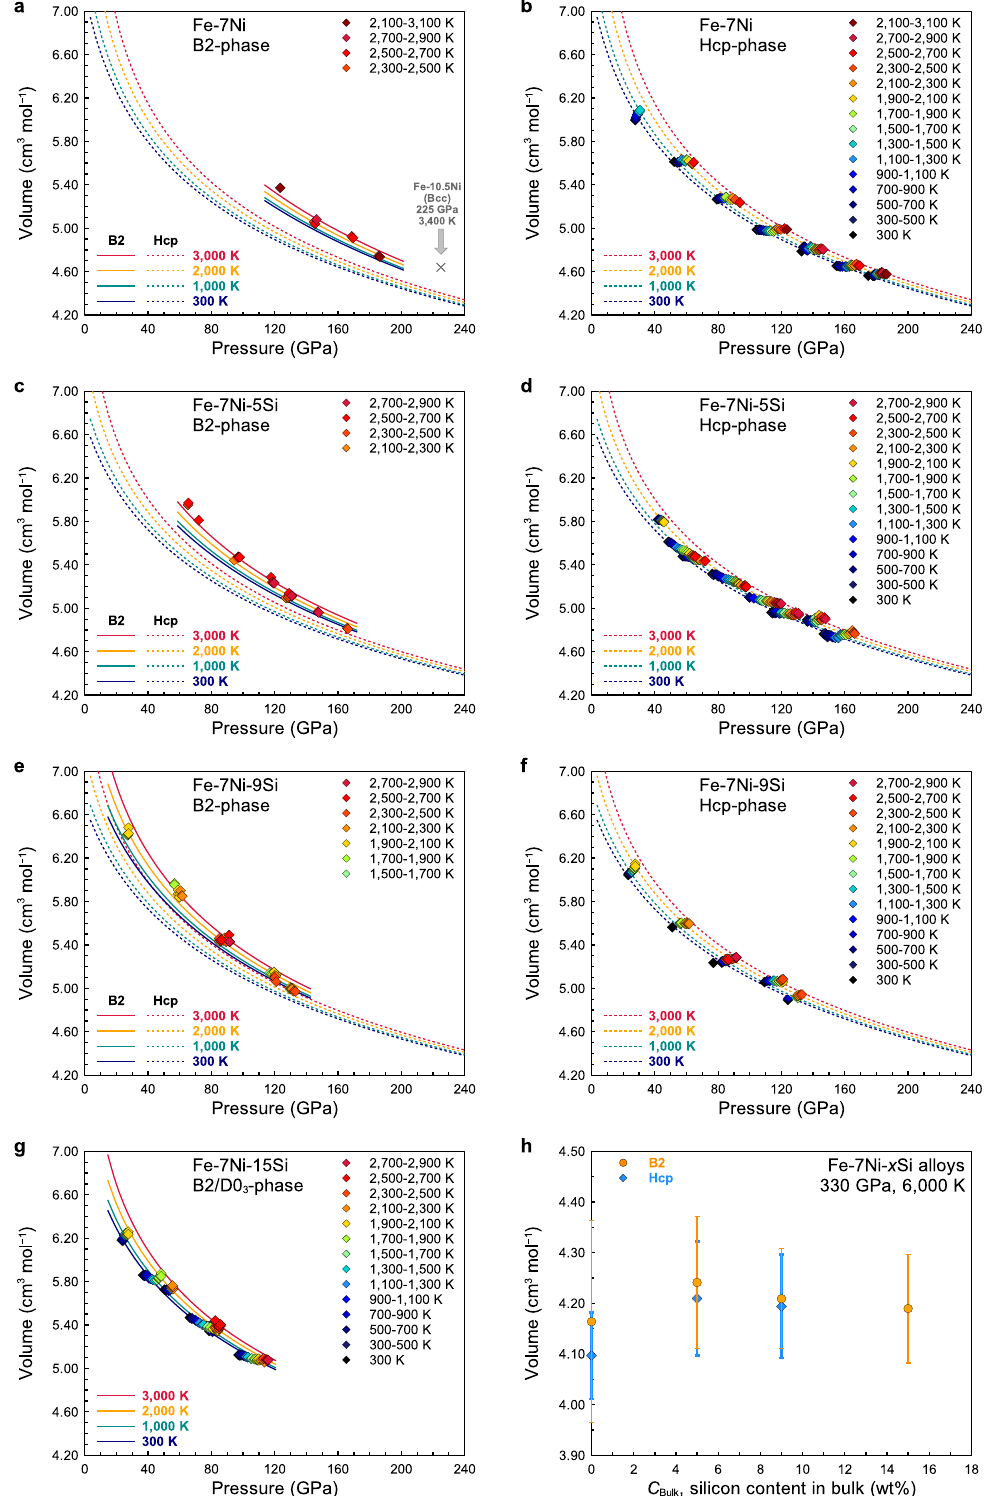
Fig. 3 Volume compression and equation of state in the Fe – Ni/Fe – Ni – Si system. a Fe – 7Ni (B2 phase), b Fe – 7Ni (hcp phase), c Fe – 7Ni – 5Si (B2 phase), d Fe – 7Ni – 5Si (hcp phase), e Fe – 7Ni – 9Si (B2 phase), f Fe – 7Ni – 9Si (hcp phase), and g Fe – 7Ni – 15Si (B2 or D0 3 phase) at high pressure and temperature. ×: bcc phase of Fe – 10.5Ni at 225 GPa and 3400 K 7 . Errors are within symbols. The silicon contents of the B2 phase in the starting materials of Fe – 7Ni – 5Si and Fe – 7Ni – 9Si may be larger than these compositions. h The molar volumes of B2 and hcp phases with different compositions at ICB conditions. Error represents 1 σ